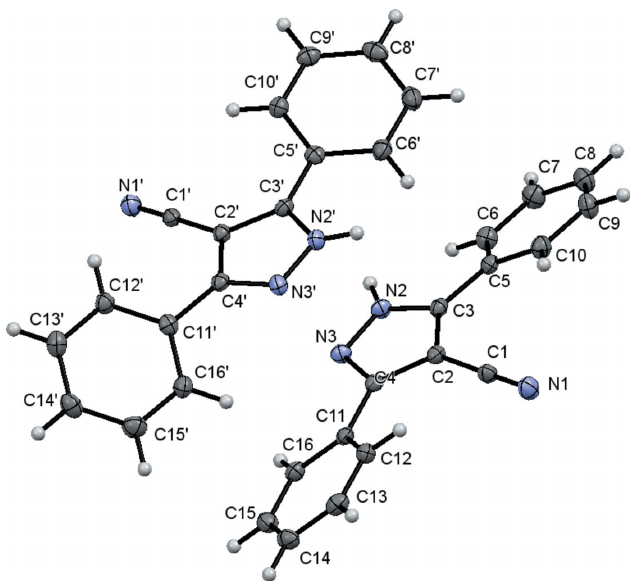
Figure 1 A view of the asymmetric unit of the title compound. Displacement ellipsoids are drawn at the 50% probability level. Hydrogen atoms are shown as spheres of arbitrary radii.